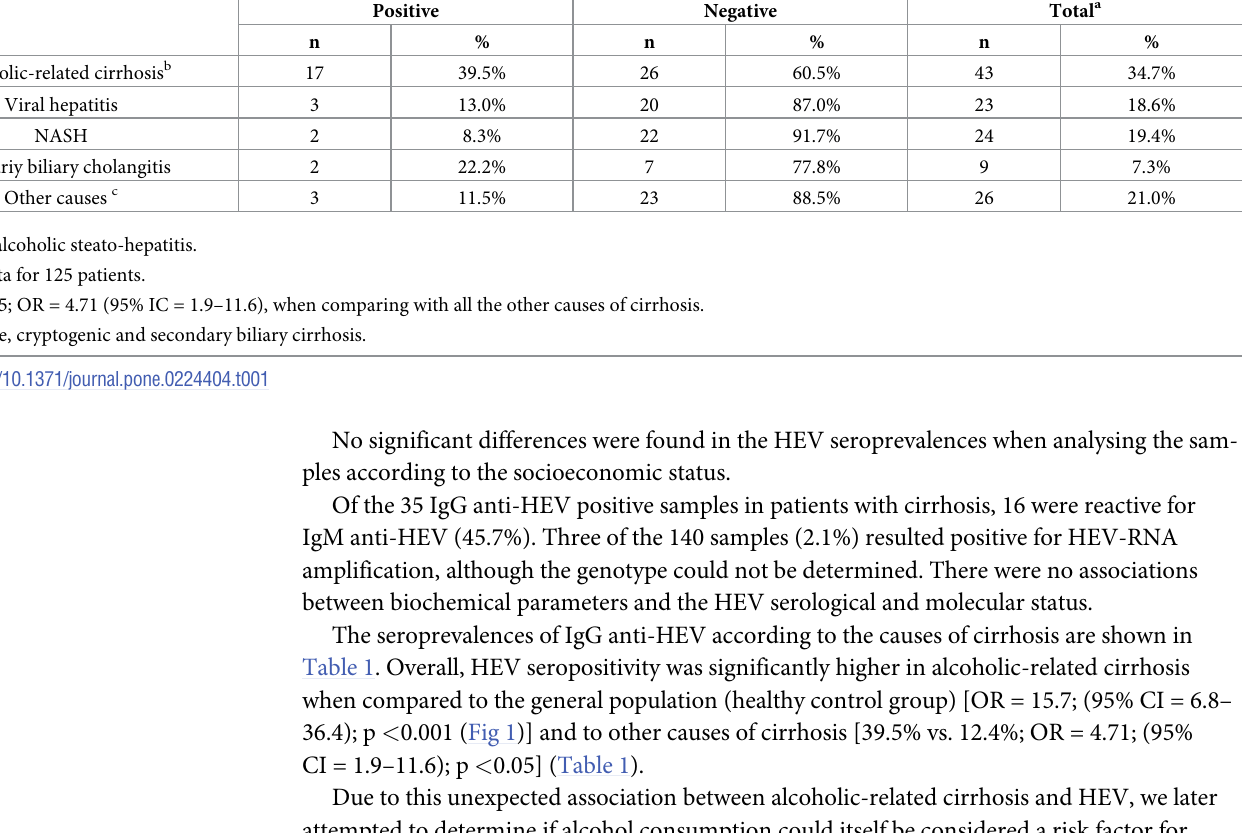
Table 1. IgG anti-HEV serostatus in patients with cirrhosis according to the causes of cirrhosis.